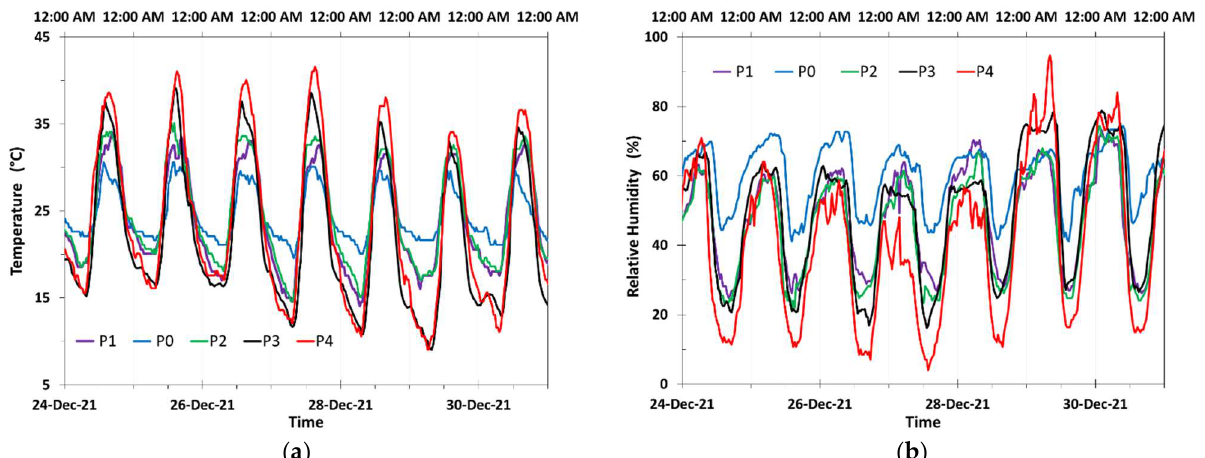
Figure 3. One-week temperature ( a ) and relative humidity ( b ) measurements from ground-level sensors. Table 2. Global average and average oscillations of temperature and relative humidity values